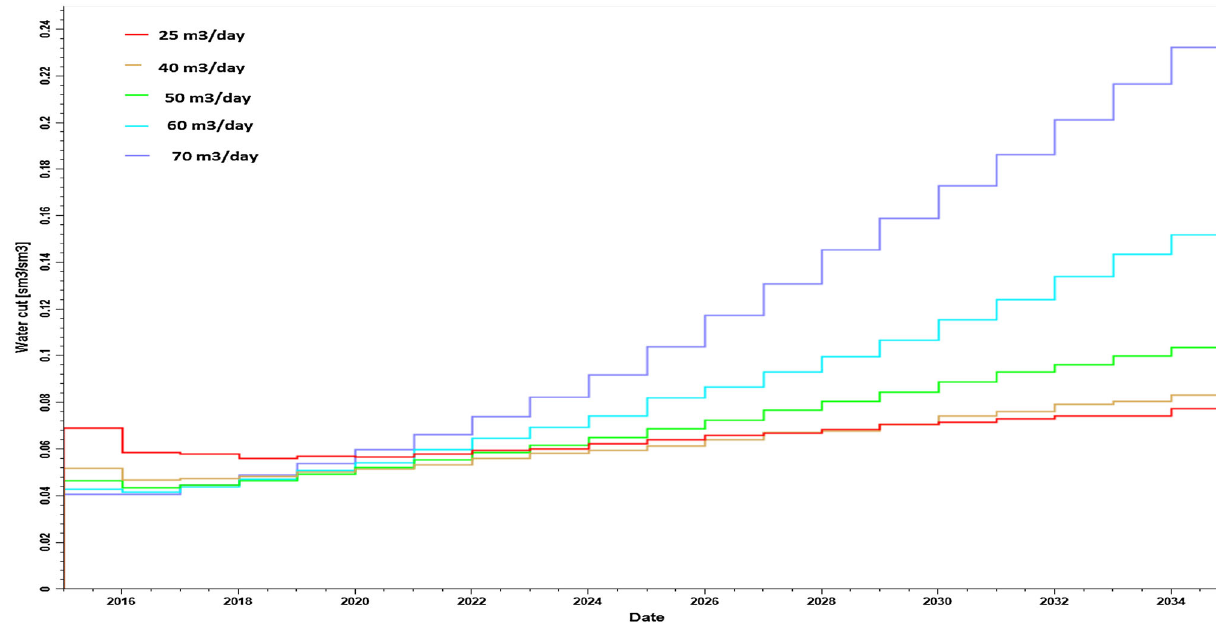
Fig. 13 Results of Group-4 simulation runs (for lower rates)